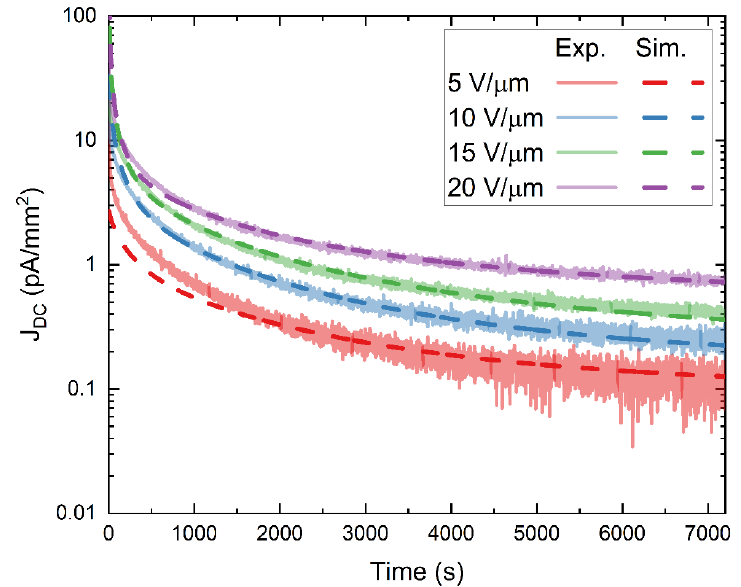
Figure 11. Simulated (dashed lines) and experimental (solid lines) DC kinetics data plotted in a semi- log scale corresponding to a PI/a-PbO detector biased at selected fields (5–20 V/ µ m) for two hours. Here the model is modified by treating the release times ( τ r , m ) and capture times ( τ c ) as electric field dependent parameters in accordance with the hopping enhanced release and capture mechanisms discussed above.